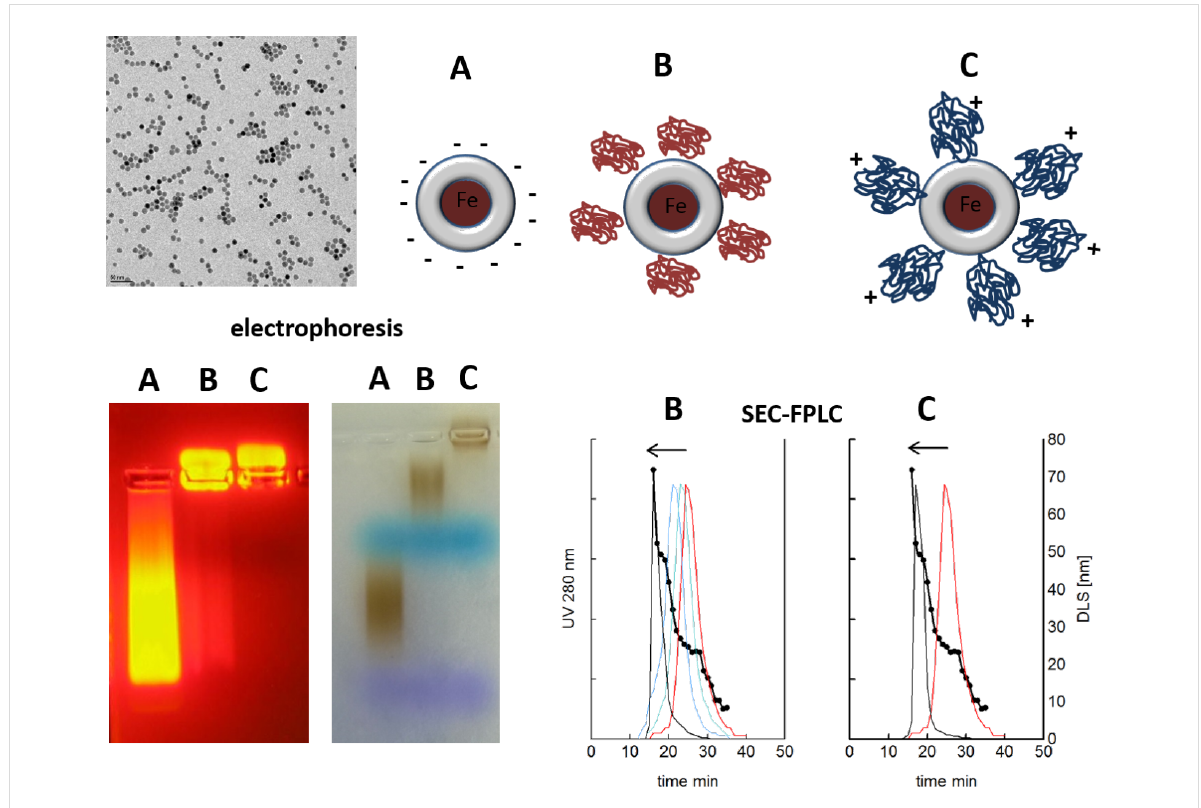
Figure 1: Synthesis and characterization of polymer-coated SPIOs with different surface charge due to PEGylation with mono- or bifunctional PEGs. Monodisperse oleic acid stabilized iron oxide cores (11 nm iron oxide core, see electron micrograph) were used as starting material. Whereas our polymer coated model SPIOs (A) is negatively charged due to free carboxyl groups (25 nm, hydrodynamic diameter), reaction with methoxy-PEG amine resulted in a more neutral particle (B), reaction with PEG-bisamine in an even cationic particle (C) as seen in electrophoresis (left Quantum dots, right SPIOs with the same polymer-coating and the same pegylation). Modification of the EDC concentration resulted in gradually PEGylated products, which can be detected by increasing size (arrows) in size-exclusion-FPLC and DLS. The FPLC was calibrated with human plasma by DLS- analysis of proteins in collected fractions (closed circles).